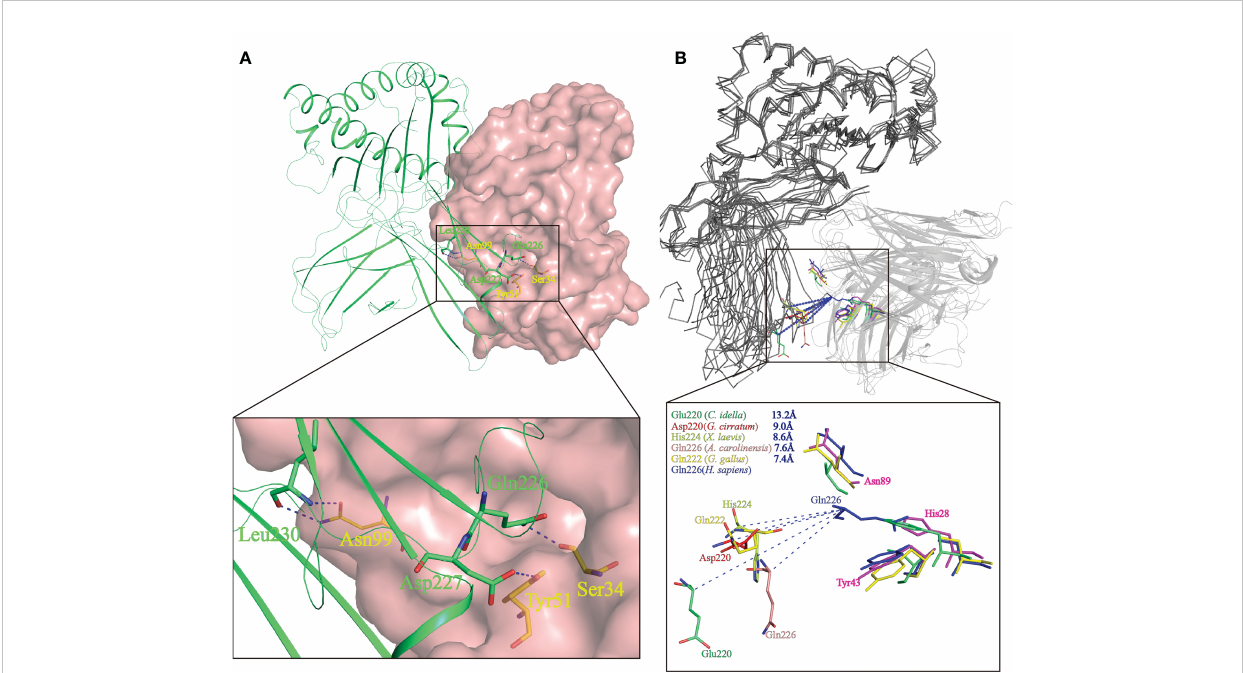
FIGURE 8 Prediction of the key intermolecular forces maintaining the interaction between Sc CD8 aa and p/MHC I molecules. (A) The interaction between human CD8 aa and p/MHC I Human MHC is shown as a lime green cartoon structure while the surface of human CD8 aa is rendered in pink. The key amino acid side chains of the interaction between CD8 aa (yellow) and p/MHC I (green) are shown. Key hydrogen bonds at the interface of human CD8 aa and p/MHC I (PDB ID: 1AKJ) are indicated by blue dashed lines. (B) The shift distance between the CD loops reveals a different binding mode of CD8 in non-mammals. The MHC I molecules are shown as gray ribbons and the CD8 aa structure as cartoon with a transparency of 50%. The shift distance is indicated by blue dash lines. Key residues in the CD loop of MHC I and the corresponding residues interacting with the CD8 aa molecules are shown as sticks. Residues of MHC I and CD8 aa of grass carp (limegreen), nurse shark (red), African clawed frog (limon), chicken (yellow) and human (blue) are